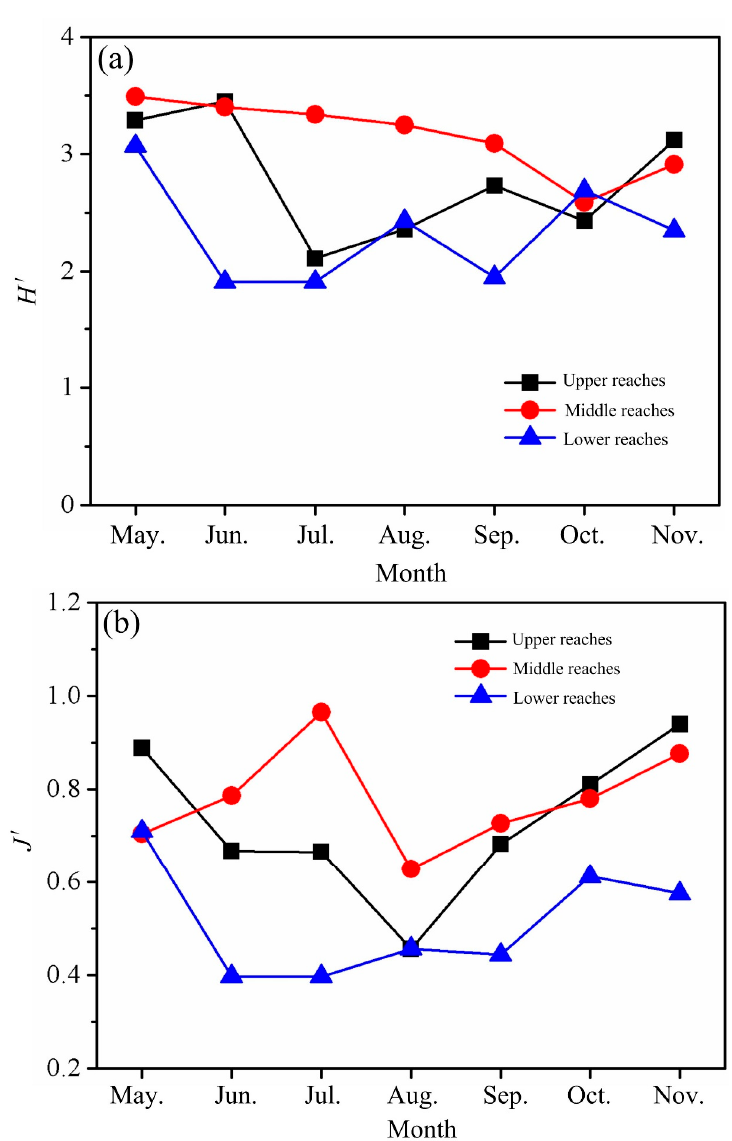
Figure 6. Spatial and temporal variations of Shannon–Wiener: ( a ) The Shannon species diversity index; ( b ) Pielous’s evenness index.